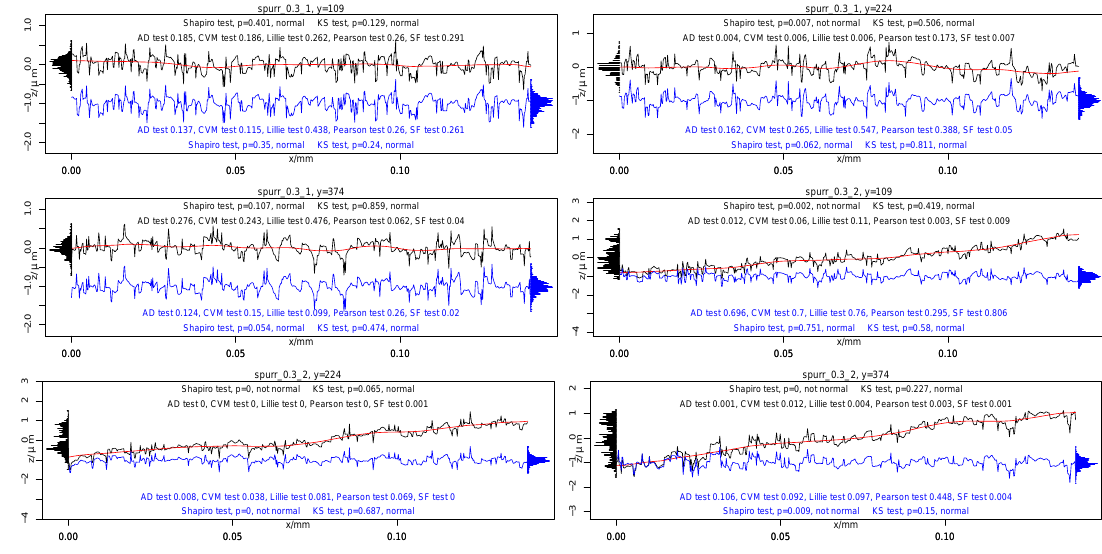
Figure 3. Roughness data of the tested surface with nominal asperity size 0.3 µ m obtained by white light interferometer: original data (black), waviness (red) and profile with removed waviness (blue); x -scale units are mm. The height distributions are given on the left and the right, respectively.